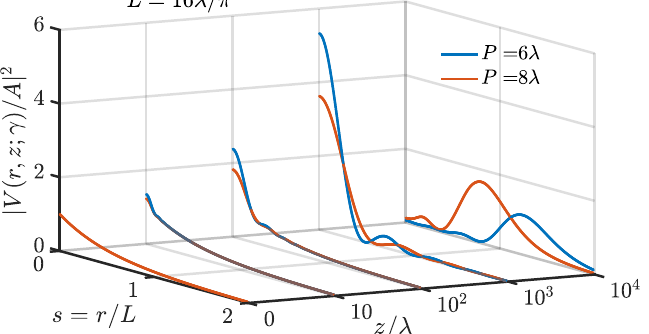
Figure 1. Evolution of the field. The curves for z / λ = 10 4 are multiplied by a factor 100 and their s axis is compressed by a factor